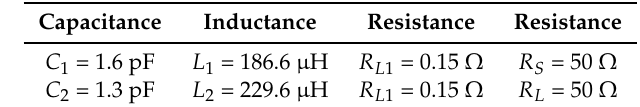
Table 1. Calculated elements of two-loop strongly coupled WPT system with high Q of coils, used to build a practical system.